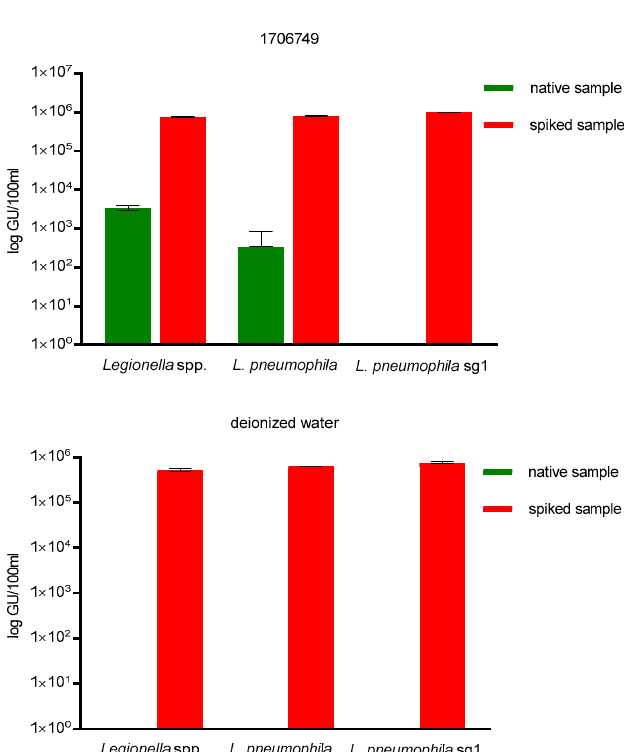
Figure 2. Target specificity control for all three qPCR assays. All three cooling water samples (1706745, 1706747, 1706749) and the sterilized, deionized water had a mean recovery of the ~9.25 × 10 5 GU/100 mL ( ± 1.45 × 10 5 GU/100 mL) L. pneumophila sg 1 of